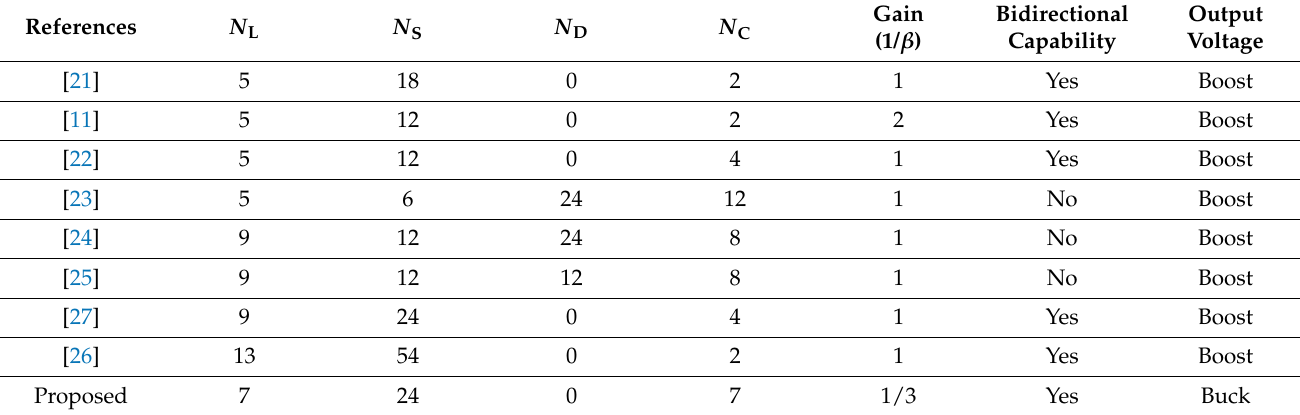
Table 4. Comparative analysis with existing three-phase PFC rectifier